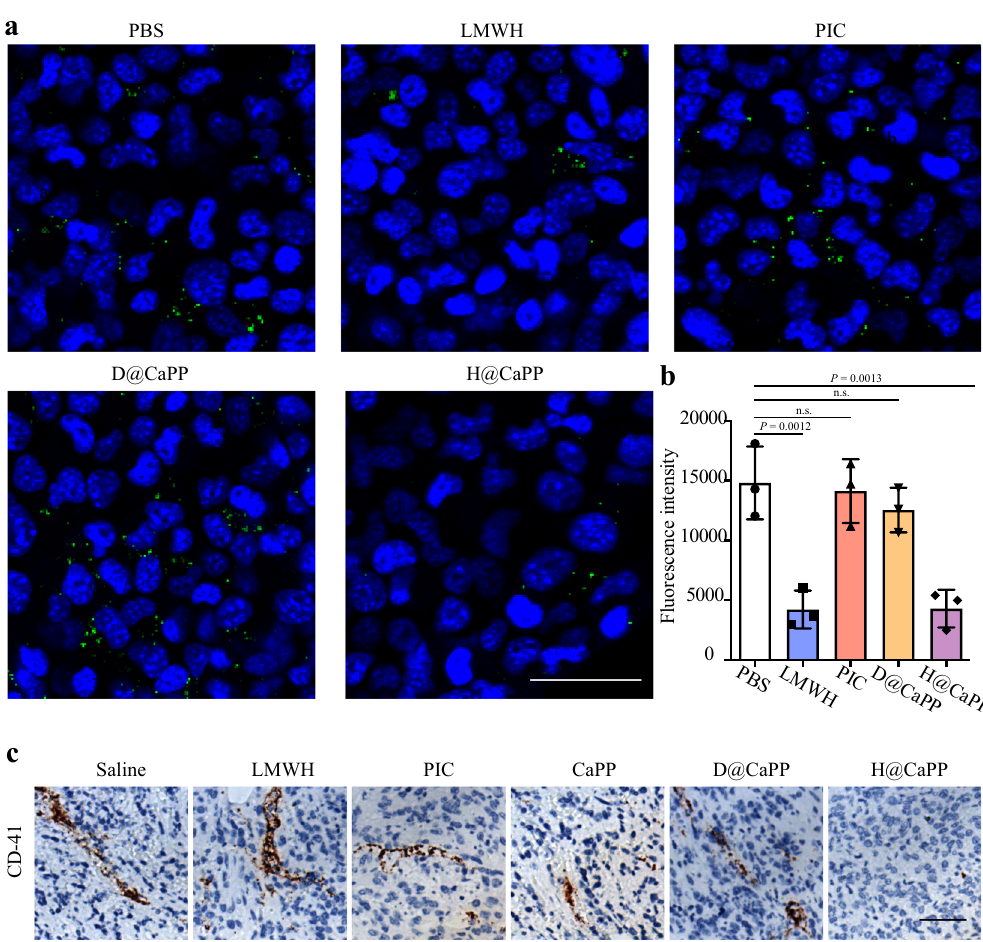
Fig. 6 H@CaPP inhibited the formation of “ micro-thrombi ” by inhibiting the adhesion of platelets to tumor cells. a Adhesion of platelets to 4T1 cells, and the inhibitory effect of PBS, LMWH, piceatannol, D@CaPP, and H@CaPP (dose of free piceatannol or PP at 10 μ M, dose of Dextran or LMWH at 1.3 mg/mL). The nuclei of 4T1 cells were stained with Hoechst 33258, and platelets were obtained and labeled with calcein-AM (green). Scale bar, 50 μ m. b The fl uorescence intensity analysis of platelets adhering to 4T1 cells (n.s. indicates no signi fi cant difference with that of PBS, ANOVA, mean ± SD, n = 3 fi elds per group). c IHC analysis of CD-41 in tumors after intravenously administrated with saline, LMWH, piceatannol, D@CaPP, and H@CaPP (i.v. at a dose of piceatannol or PP at 0.020 mmol/kg, at a dose of Dextran or LMWH at 10 mg/kg) for seven times in 14 days. Scale bar, 50 μ m. One-way ANOVA with Tukey ’ s multiple comparisons test (one-sided) was used for b . Error bars represent